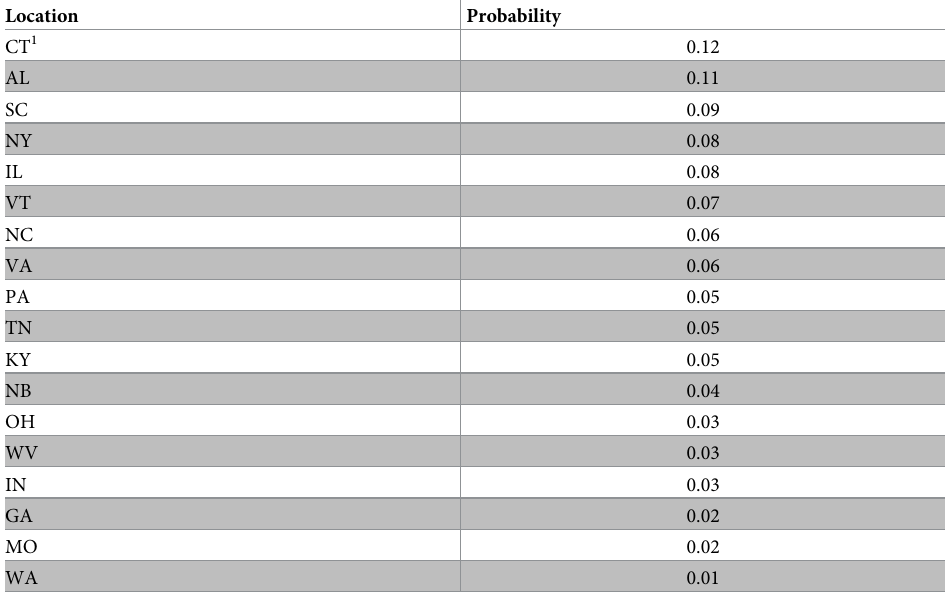
Table 3. The root location probability retrieved from the summary tree location file from BEAST